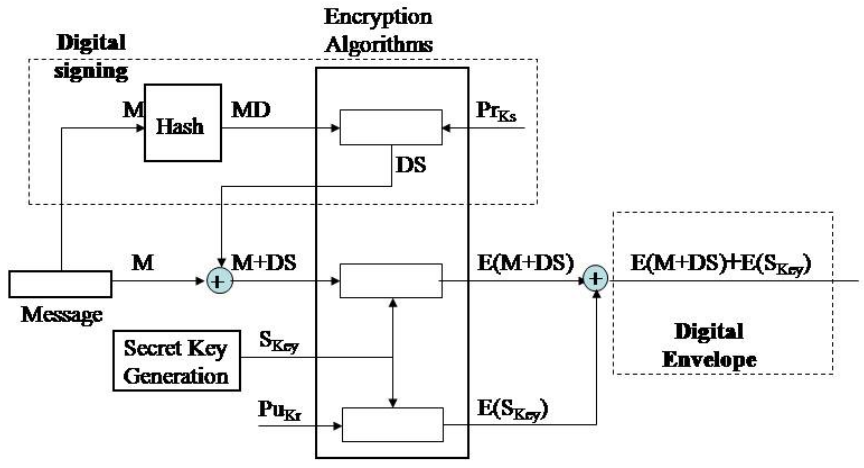
Figure 2. Detailed overview of the message protection in the transmission process.